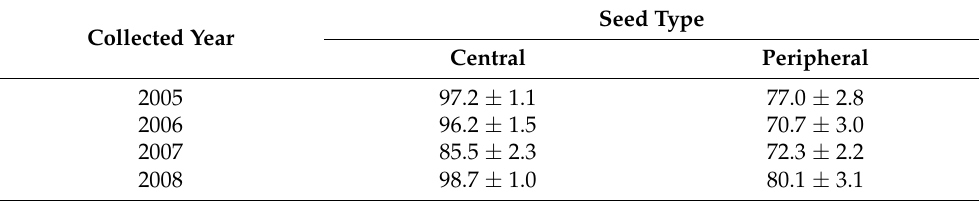
Table 1. Viability percentage of seeds (mean ± SE) according to the tetrazolium